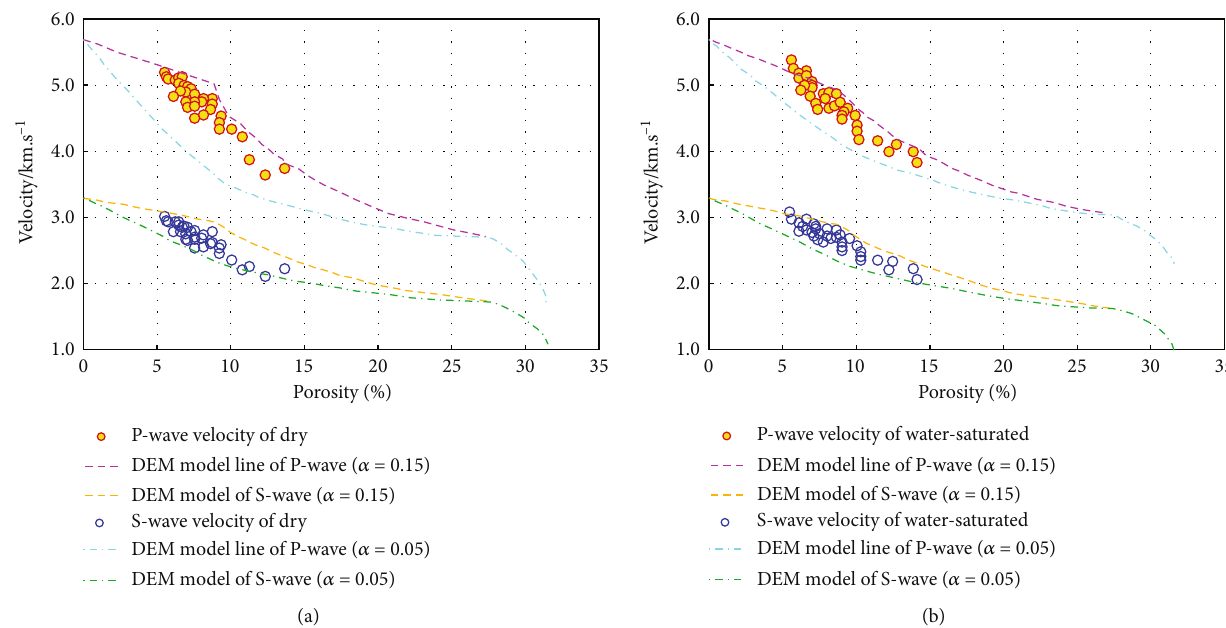
Figure 11: The cross plot of sonic velocity and porosity, Baikouquan sandy conglomerate reservoirs.